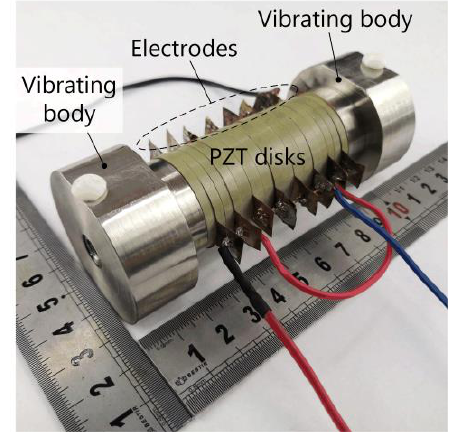
Figure 2. Photograph of the transducer prototype.